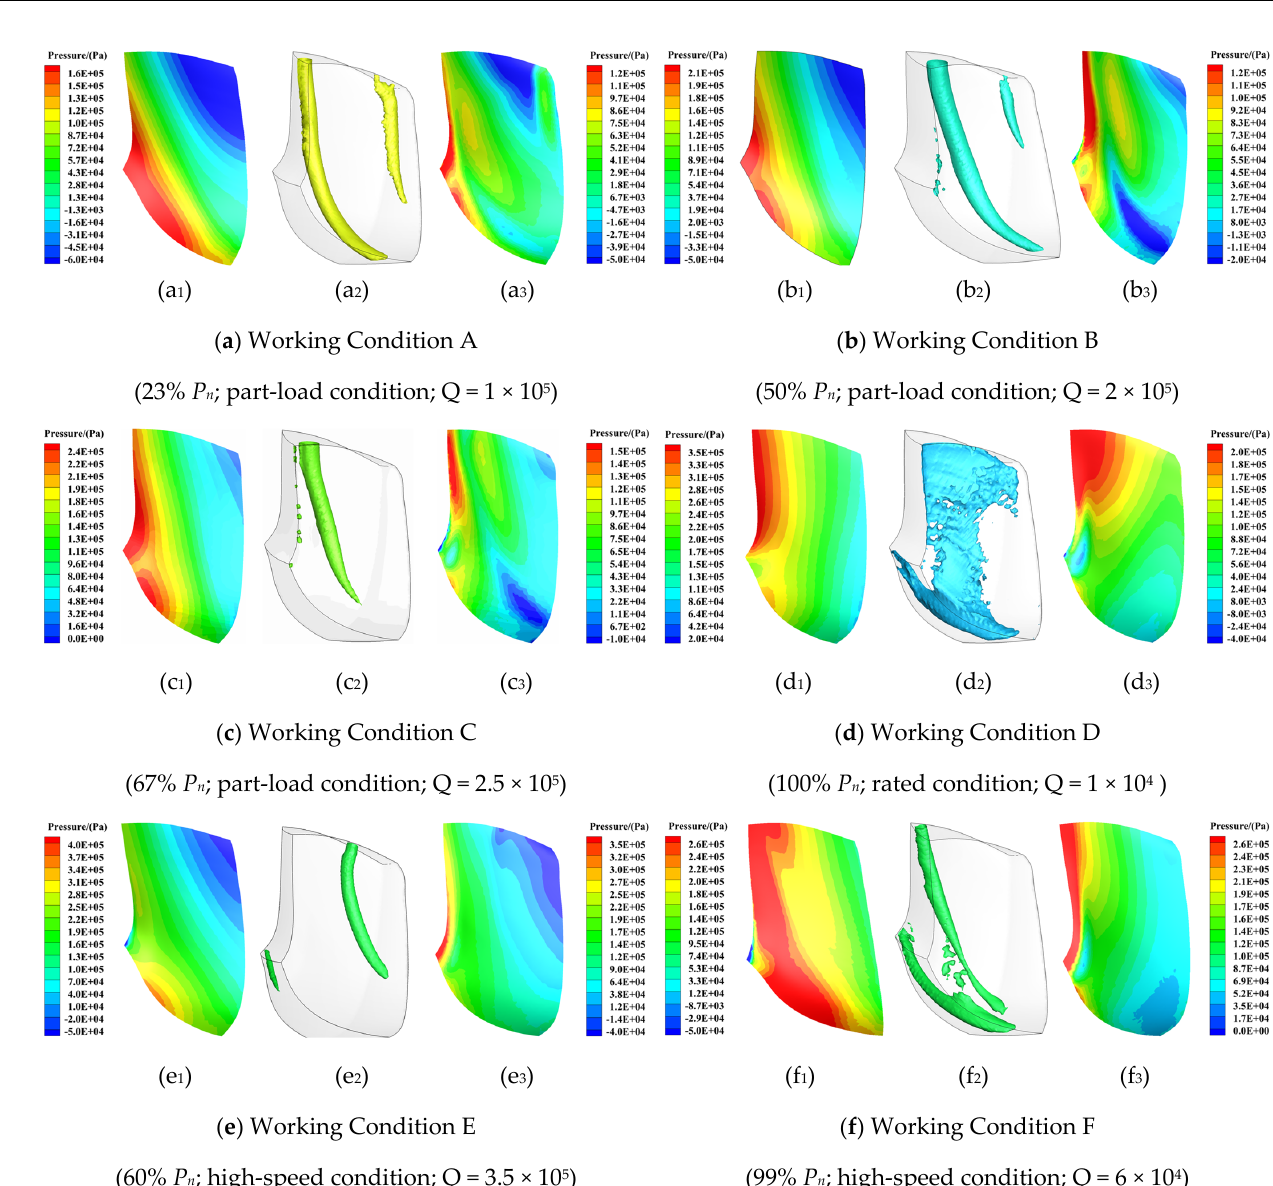
Figure 11. Contours of static pressure distribution on the wall of runner vanes. Note: ( a 1 – f 1 ) are contours describing the pressure distribution of the pressure surface of the blade; ( a 2 – f 2 ) are structures of channel vortexes captured by Q criterion in the blade passage; and ( a 3 – f 3 ) are contours describing pressure distribution in the suction surface of the vane.